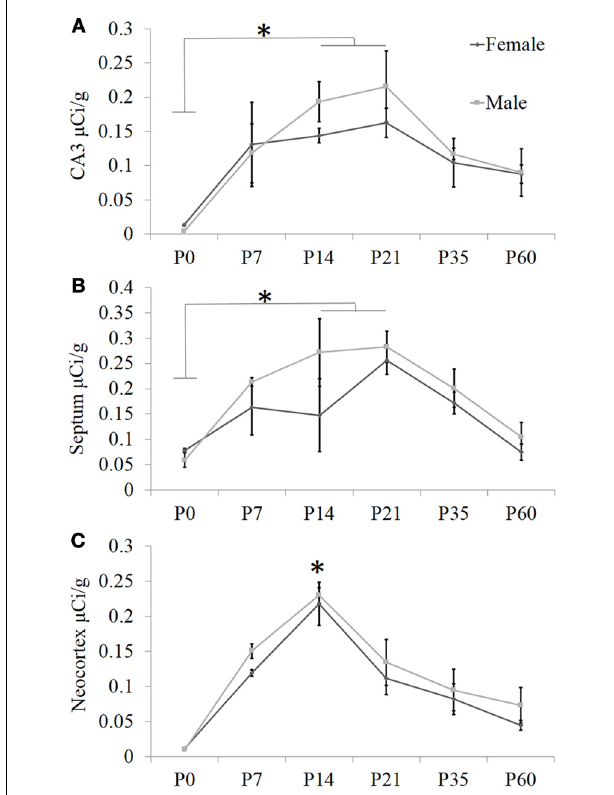
FIGURE 2 | Quantification of receptor autoradiography for OXTR in C57BL/6J mice demonstrates transient developmental profiles. OXTR binding with highly selective OXTR ligand is evident in (A) the CA3 of the dorsal hippocampus, (B) the septum, and (C) the neocortex sampled at S1. For all three brain regions, there was a main effect of age. In the septum and the hippocampus, this was driven by the difference in binding between P0 and P14–P21. In the neocortex, the main effect of age was stronger and driven substantially by the peak at P14. ∗ p < 0 . 05.